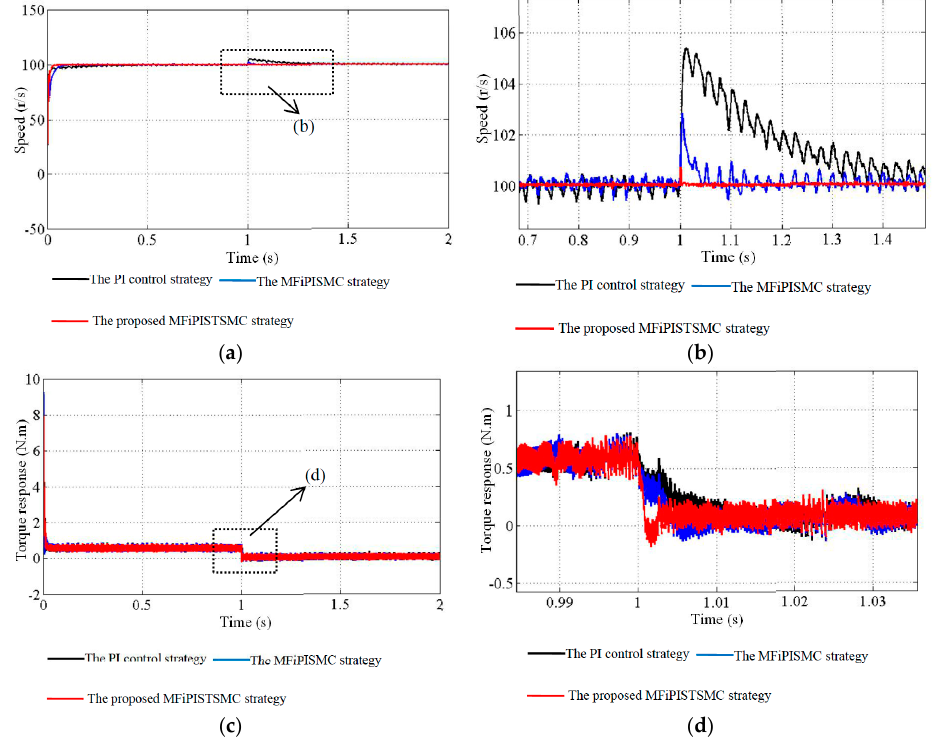
Table 5. The comparative results of the load decreased suddenly.